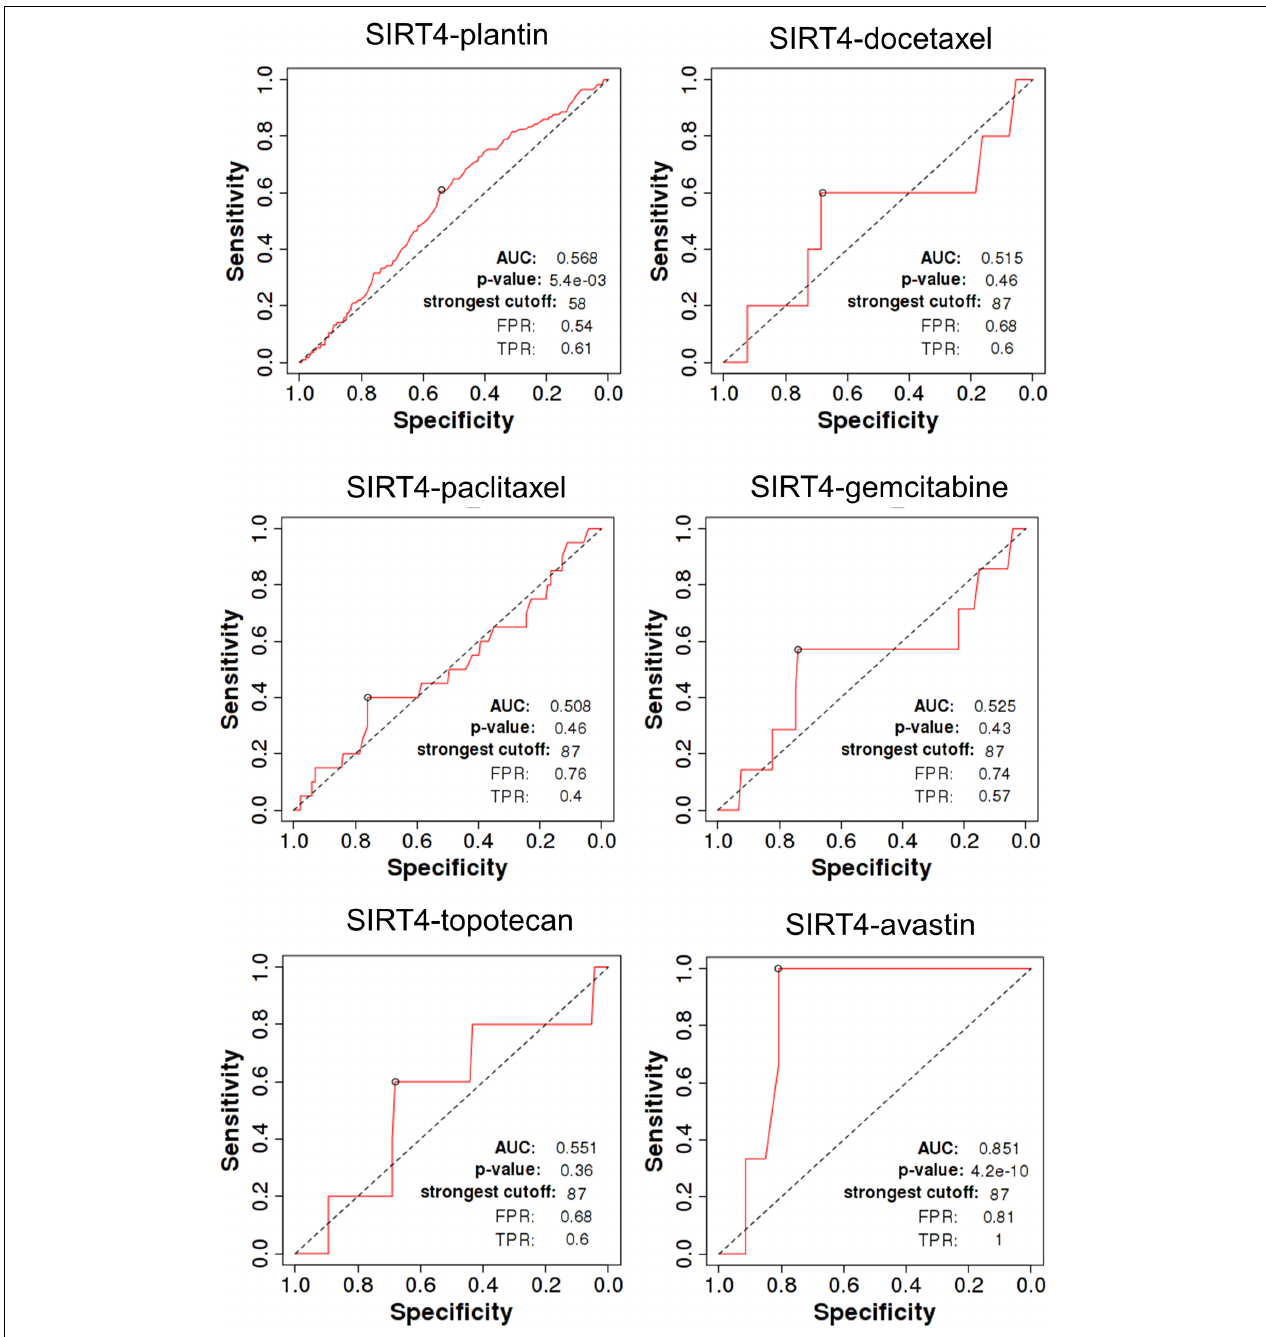
FIGURE 5 | Receiver operating characteristic (ROC) curve of SIRT4 in ovarian cancer patients under the indicated drug treatment for relapse-free survival time at 6 months. AUC, area under curve; FPR, false positive rate; TPR, true positive